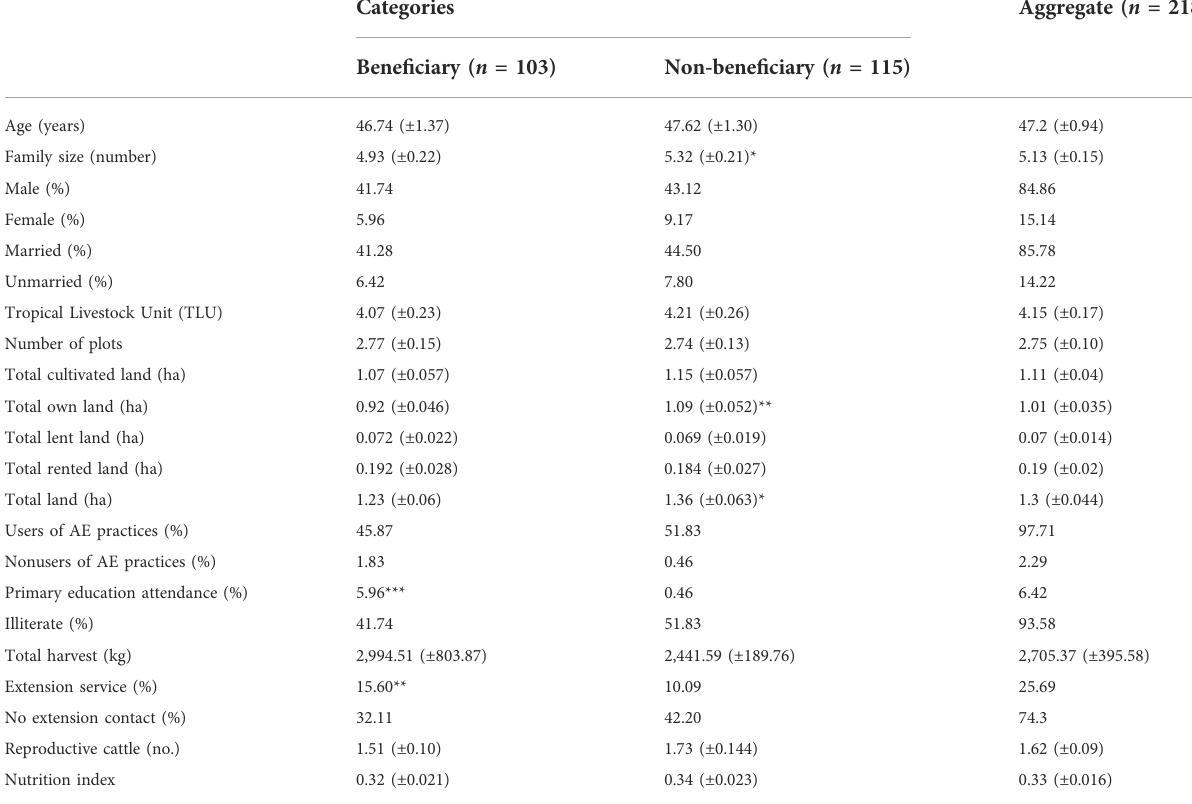
TABLE 2 Socio-economic characteristics of the